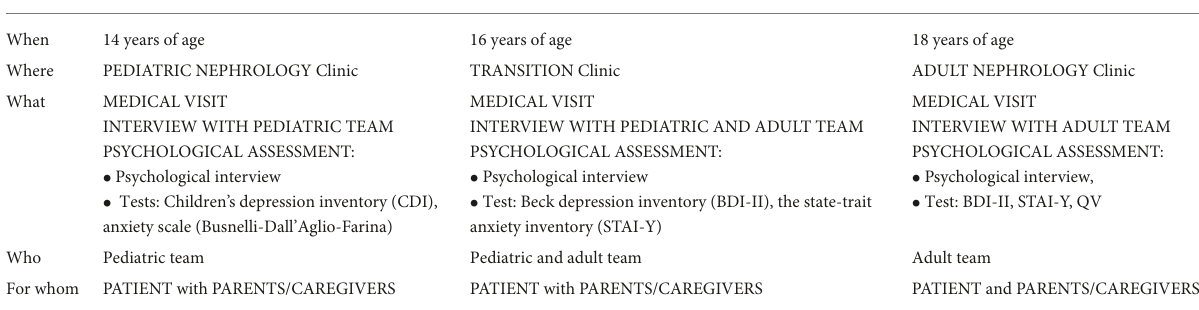
TABLE 1 Outline of the stages of the transition process from pediatric to adult